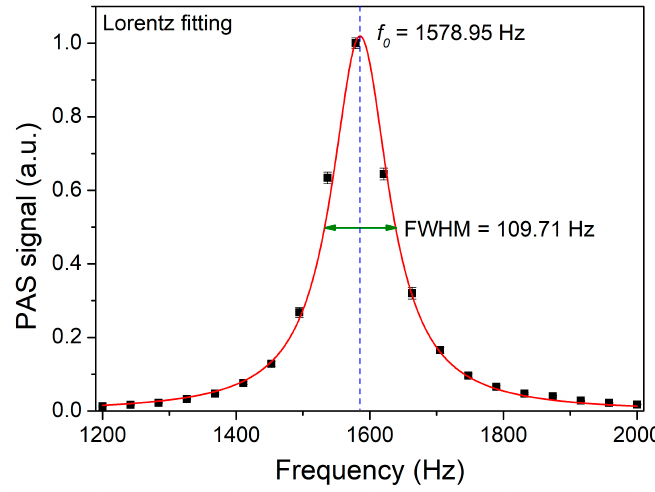
Figure 5. Frequency response of the photoacoustic cell. FWHM: full width at half maximum.